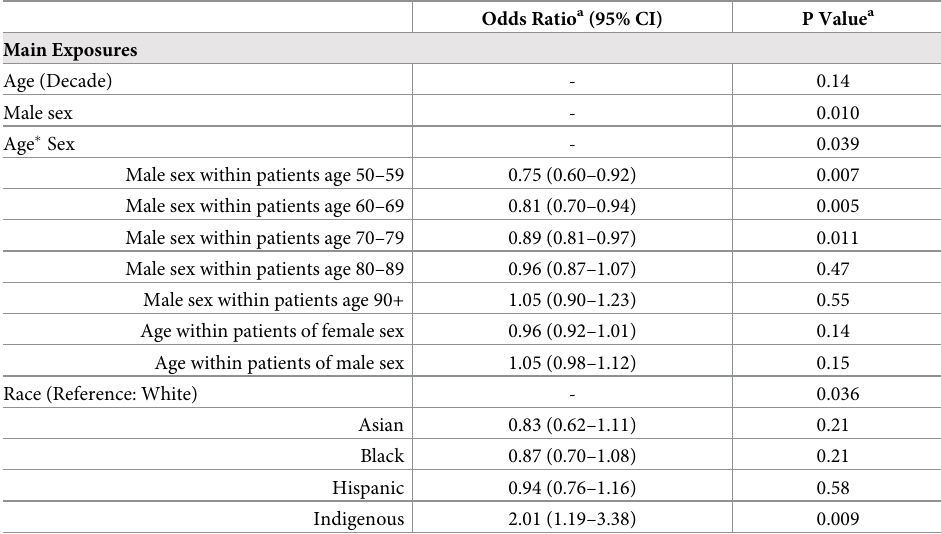
Table 3. Adjusted associations of exposures and covariates with prescription of anti-osteoporosis